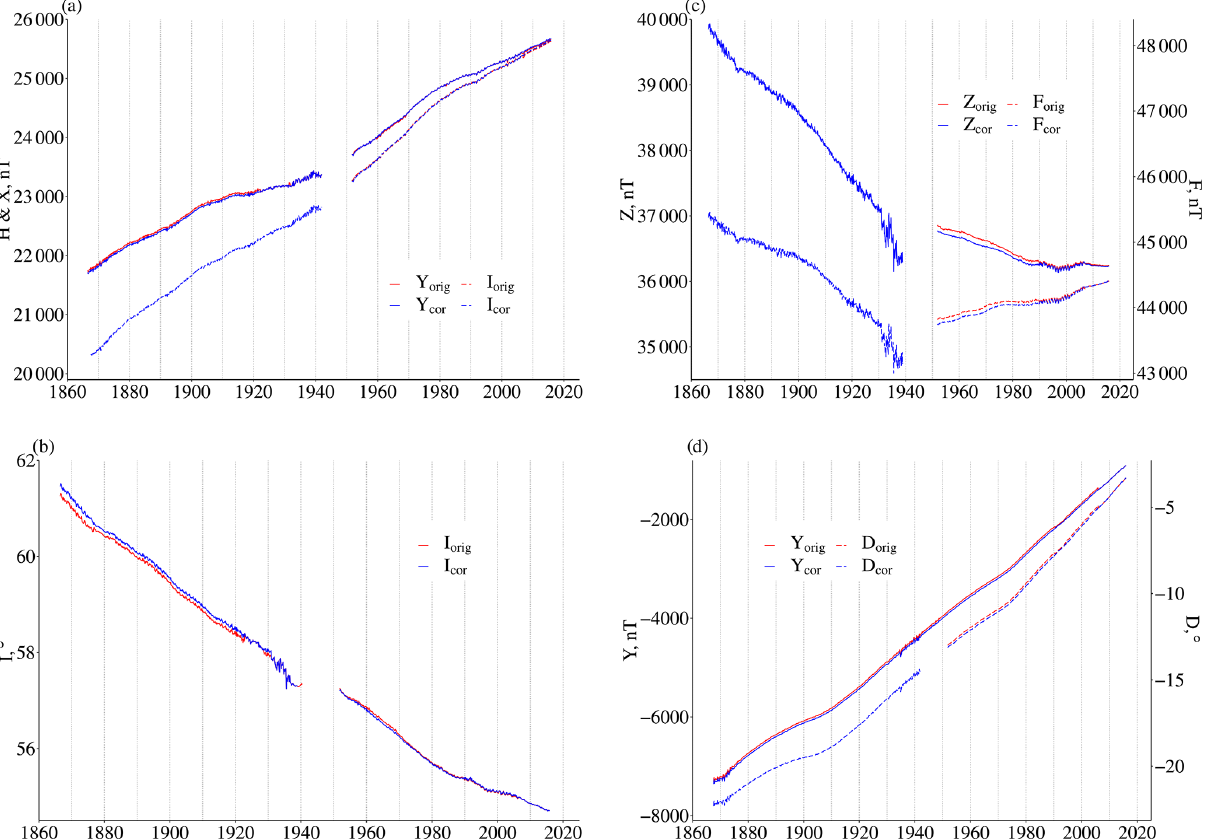
Figure 9. For the 1866–2015 time period, measured (red; orig) and corrected (blue; cor) series of the COI geomagnetic field elements (a) H and X , (b) I , (c) F and Z , and (d) D and Y